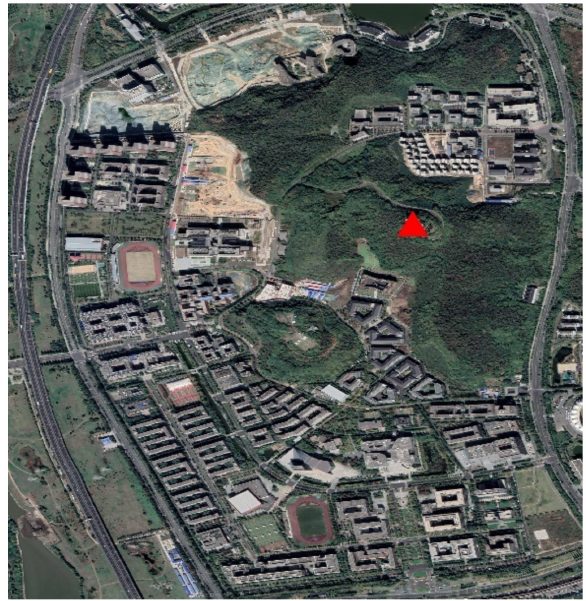
Figure 1. Satellite cloud image of Nanjing University (The triangle in the figure is the weather